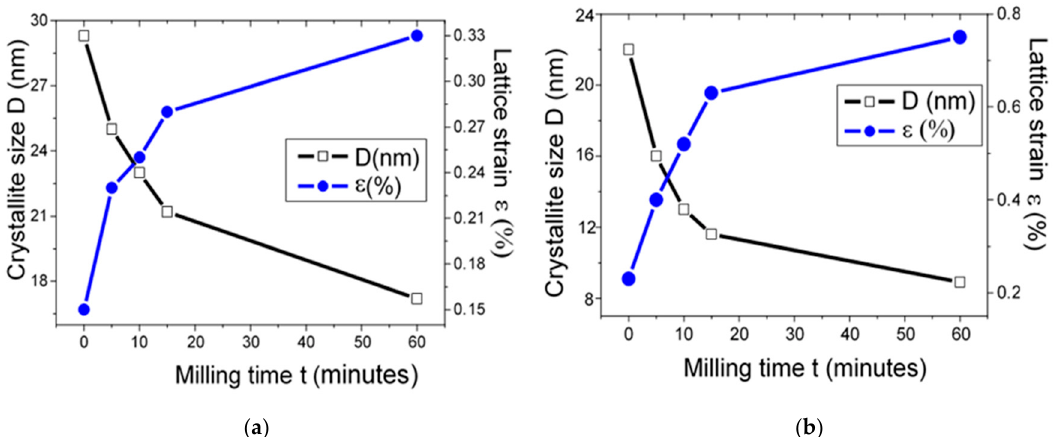
Figure 6. Crystallite size and lattice strain evolutions as function of the milling time of: ( a ) quartz, ( b ) calcite.